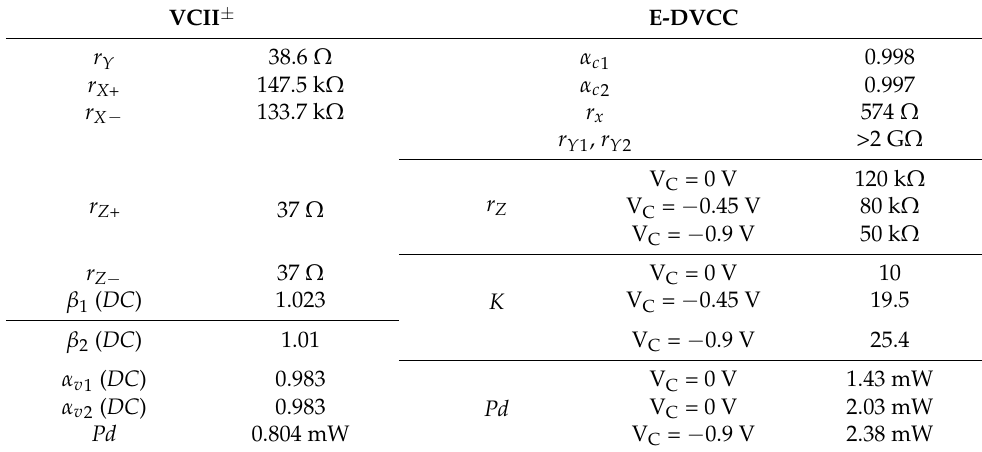
Table 2. The simulated low-frequency characteristics of VCII ± and